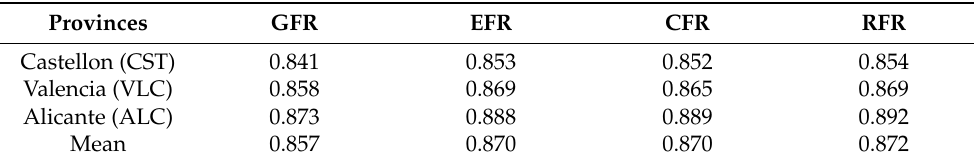
Table 8. AUC values for the FR methods.